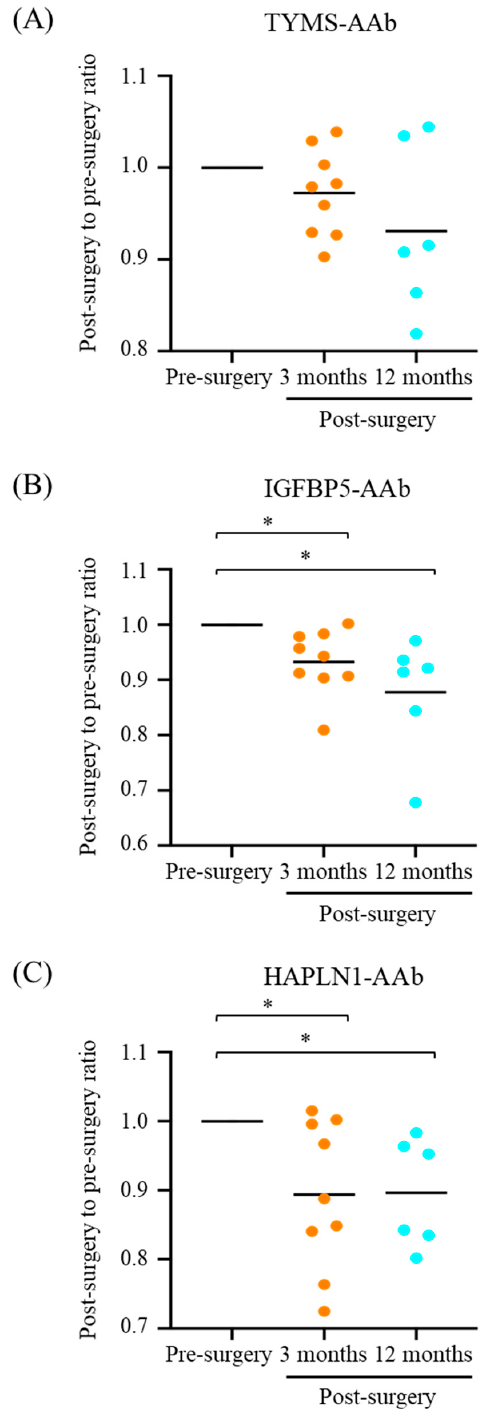
Figure 2. Serum levels of CMT-associated AAbs in dogs with malignant CMT (MMT) before and after mastectomy. Serum levels of ( A ) TYMS-AAb, ( B ) IGFBP5-AAb, and ( C ) HAPLN1-AAb in MMT dogs assessed at 3 and/or 12 months after surgery were compared with the corresponding serum AAb levels before surgery. A postsurgical-to-presurgical ratio of individual serum AAb was determined by dividing the postsurgical levels of individual serum AAbs by the matched presurgical levels for each patient. Results are presented in scatter dot plots, where the bar indicates the median. Statistical analysis was conducted with Wilcoxon signed-rank test. * p < 0.05.